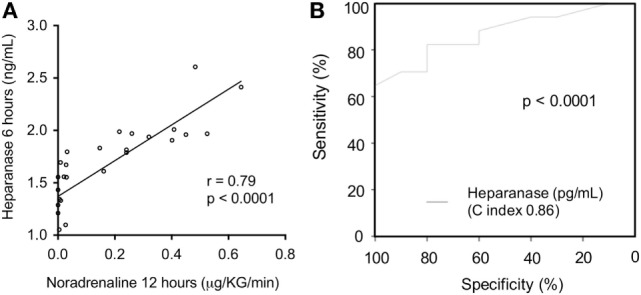
Association between postoperative serum levels of heparanase and the need of vasopressor. Serum levels of heparanase were assessed in patients undergoing open or endovascular thoracoabdominal aortic aneurysm repair (n = 27) 6 h after intensive care unit (ICU)-admission. (A) Correlation of serum levels of heparanase 6 h post-ICU admission with the noradrenaline dose 12 h after ICU admission. (B) Receiver operating characteristic curve for the value of heparanase 6 h after ICU admission in predicting the need of vasopressor within the first 24 h after ICU admission.